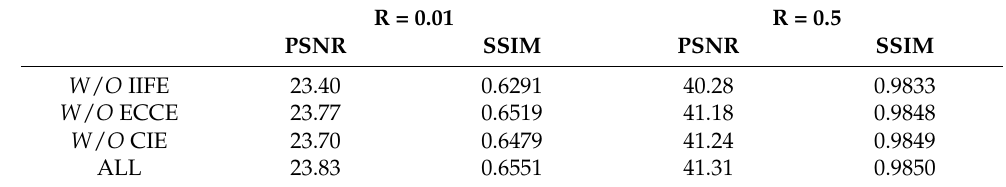
Table 4. The Ablation Experiment.